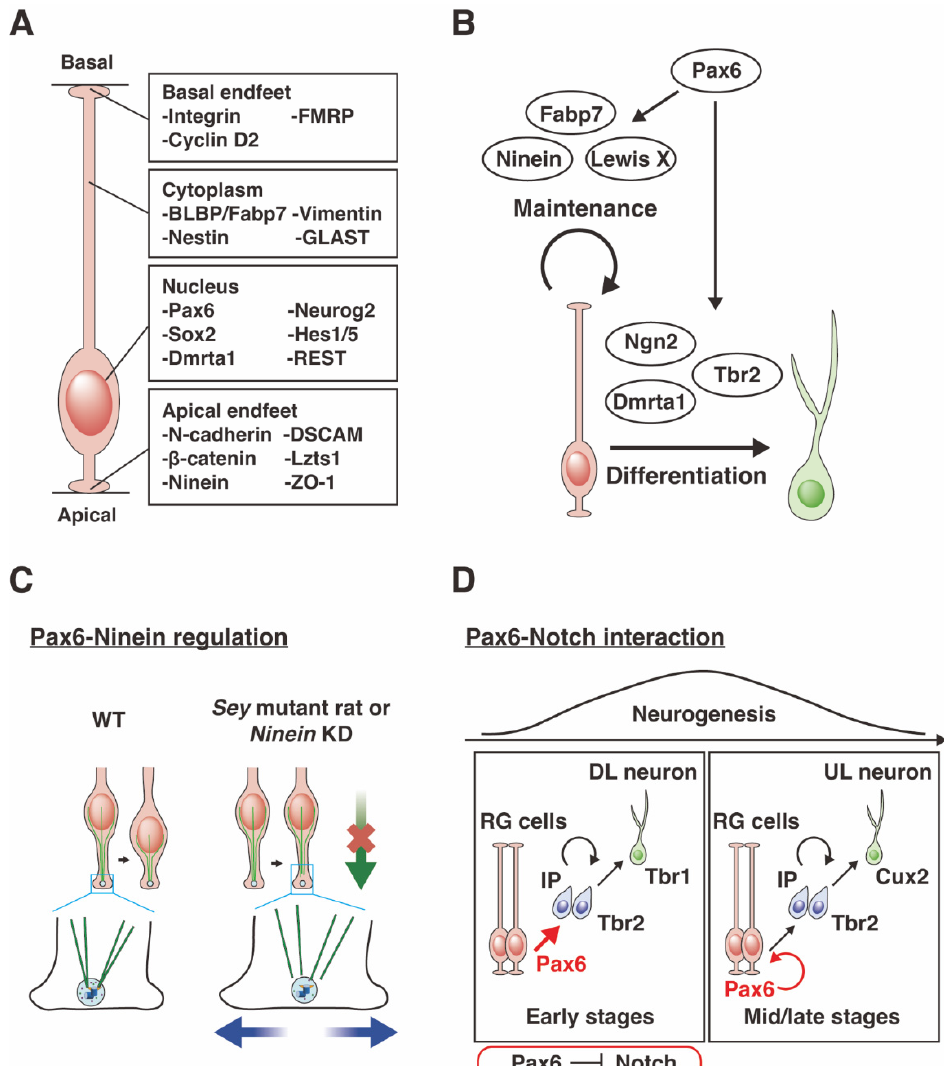
Figure 4. The function of Pax6 and downstream genes. ( A ) Subcellular gene localization in radial glial (RG) cells. Genes localized in the cell nucleus, cytoplasm, and apical and basal endfeet. The graphical diagram has been redrawn from [135]. ( B ) Downstream genes regulated by Pax6 and their roles. Pax6 regulates Fabp7 , Ninein, and Lewis X , which are involved in stem cell self-renewal. Pax6 induces Ngn2 , Tbr2, and Dmrta1 , which induce neural differentiation. ( C ) The Pax6–Ninein network regulates interkinetic nuclear migration (INM) during cell-cycle progression in neuroepithelial cells. The microtubule cytoskeleton plays an important role in INM, in which the nuclei of neuroepithelial cells move apically during G2 phase and basally during G1 phase. Ninein, downstream of Pax6, anchors microtubules during elevator movements to control the dynamics of INM. The graphical diagram has been redrawn from [99]. ( D ) Pax6–Notch interaction for neurogenic programs in the developing mouse cortex. Pax6-dependent neural differentiation by Notch signaling inhibition generates deeper layer (DL) neurons in the early neurogenic phase. Pax6-dependent self-renewal of the RG cells which give rise to upper layer (UL) neurons occurs in the middle/late neurogenic phase when Notch signaling is absent. In this way, the Pax6–Notch pathway coordinates the balance between self-renewal and neural differentiation. The graphical diagram has been redrawn from [127].